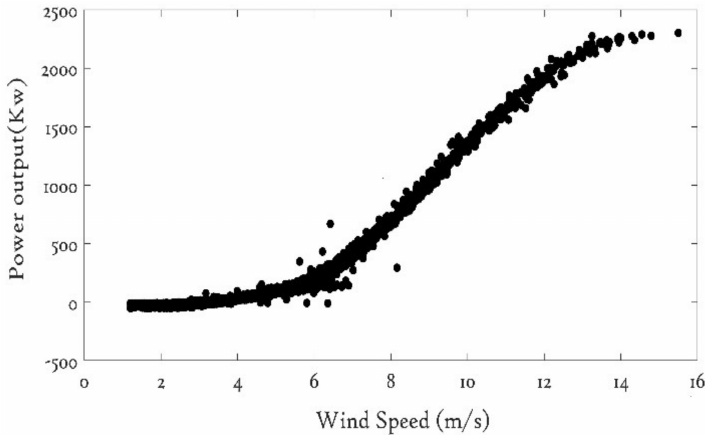
Figure 1. Measured Power